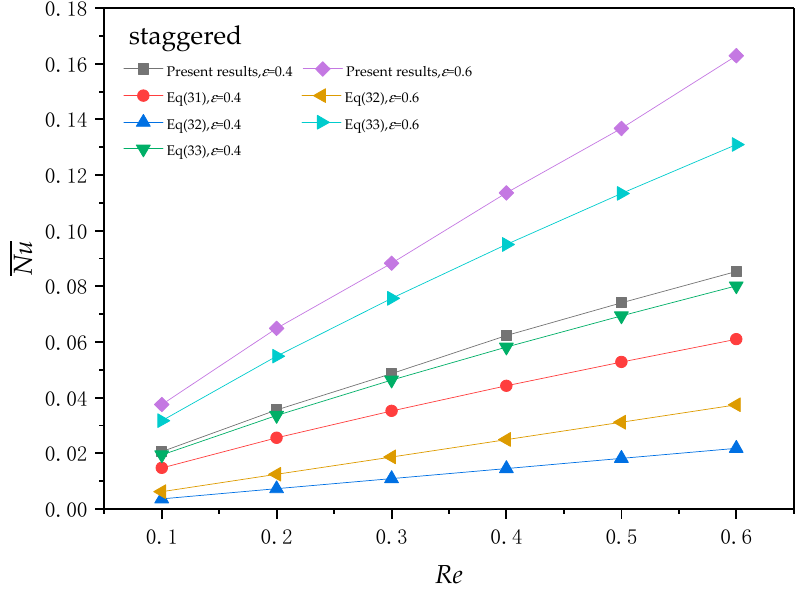
Figure 20. The relationship between average Nusselt number and Reynolds number.